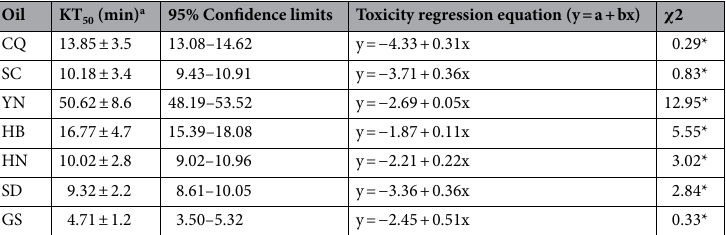
Table 3. Median lethal knockdown activity (mins) of the essential oils extracted from seven geographical regions of Ar. argyi against female adults of An. sinensis . a KT 50 represents the knockdown time of half individuals, which was determined by log-probit analysis. Three experimental repeats with the essential oil dosage of 2 µL. *Significant at p < 0.05. CQ, SC, YN, HB, HN, SD and GS: essential oils from Chongqing, Sichuan, Yunnan, Hubei, Henan, Shandong and Gansu province/municipality,